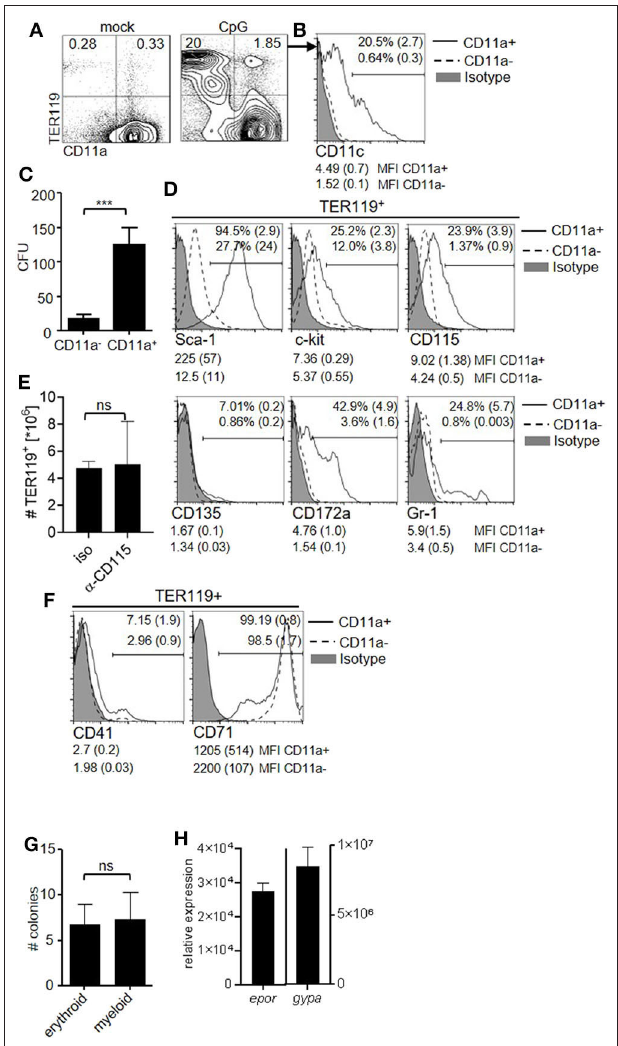
FIGURE 2 | EPO or GM-CSF. (H) Relative expression of epor and gypa transcripts in CD11c + cells derived from TER119 + CD11a + cells after culture with GM-CSF for 10 days compared to BMDC. (A–H) Representative data of at least 3 experiments with n = 4–5 animals/group are shown. (C,E,G,H) Bar graphs show mean (SD). Student’s t test was performed. Statistical significance is indicated by *** = p < 0.0001, ns = p > 0.05.